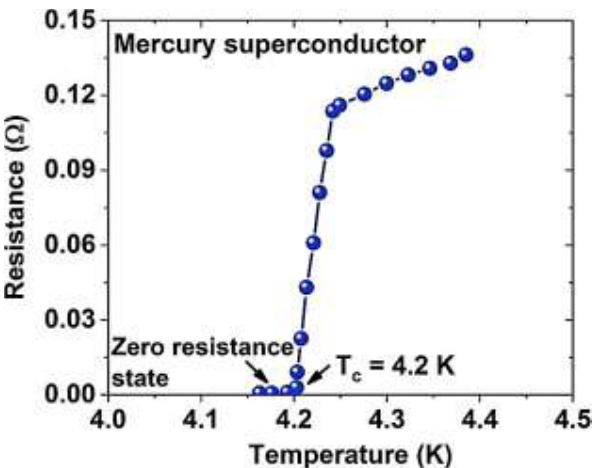
Figure 1: Illustration of Kamerlingh Onnes’ discovery of superconductivity and disappearance of the electrical resistivity of Hg element (in